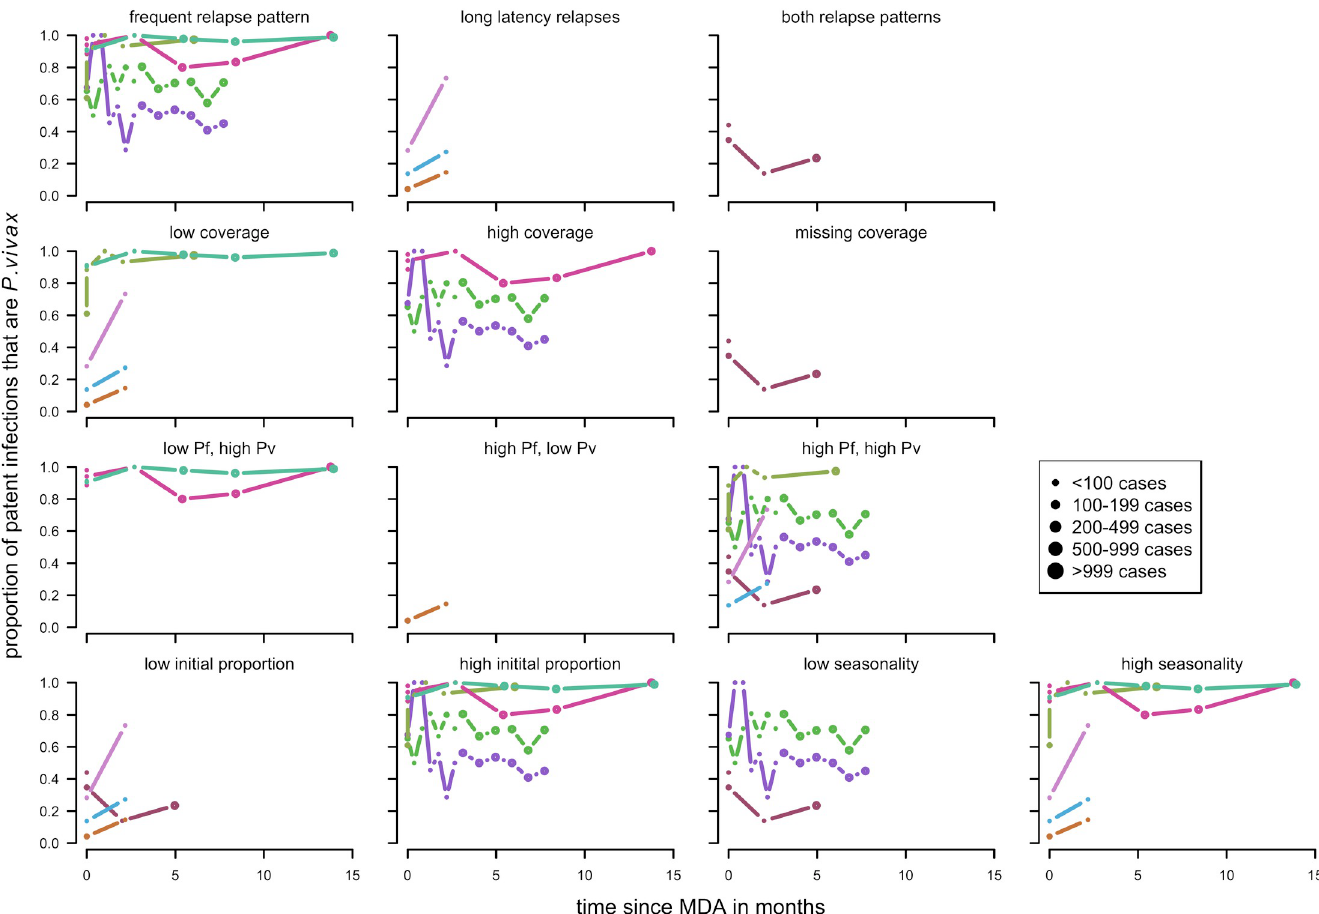
Fig 16. Spaghetti plots splitting the series of time-points of the proportion of patent infections that are P. vivax by relapse pattern, coverage, transmission intensity, initial proportion of P. vivax and seasonality after MDA. Dot size depending on number of infections.